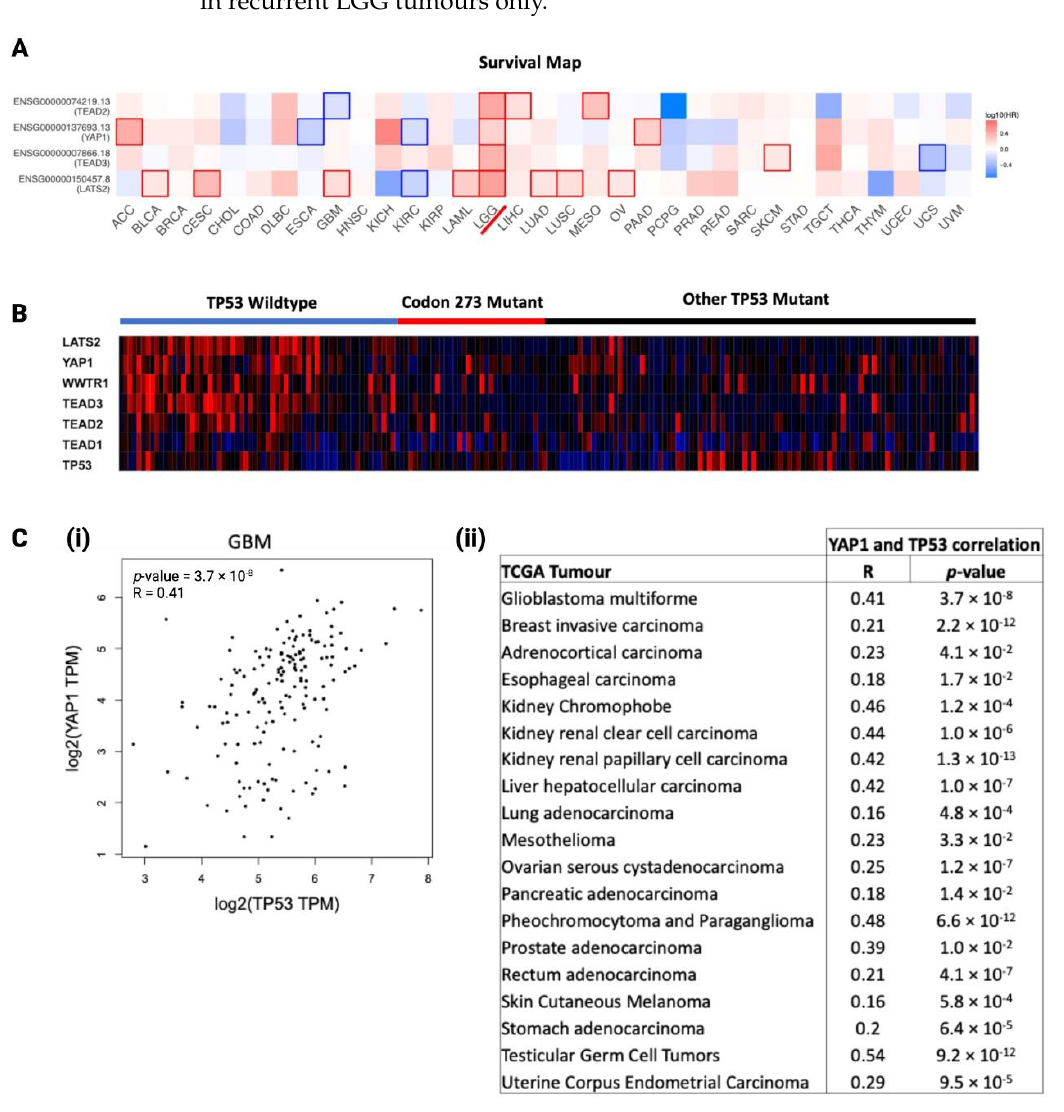
Figure 7. Association between TP53 mutation/mRNA expression with YAP1 mRNA expression, and the prognostic significance of YAP1 in cancers. ( A ) Log 10 hazard ratio (log 10 HR) of YAP1 mRNA expression (median cut-off) in TCGA cancers. LGG is marked with a red line. Statistically significant log 10 hazard ratios ( p < 0.05) are outlined with solid borders. ( B ) Hippo Signalling pathway and TP53 gene expression heatmap distribution among TP53 mutation statuses in TCGA astrocytoma as a gradient of high expression (red), neutral expression (black) and low expression (blue). ( C ) ( i ) Correlation between YAP1 and TP53 mRNA expressions in GBM. ( ii ) Correlation between YAP1 and TP53 mRNA expressions in selected TCGA cancers.